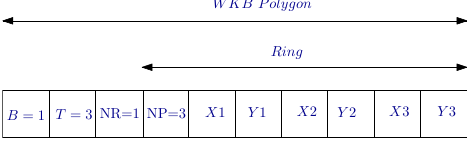
Figure 11: WKB of OGC Simple